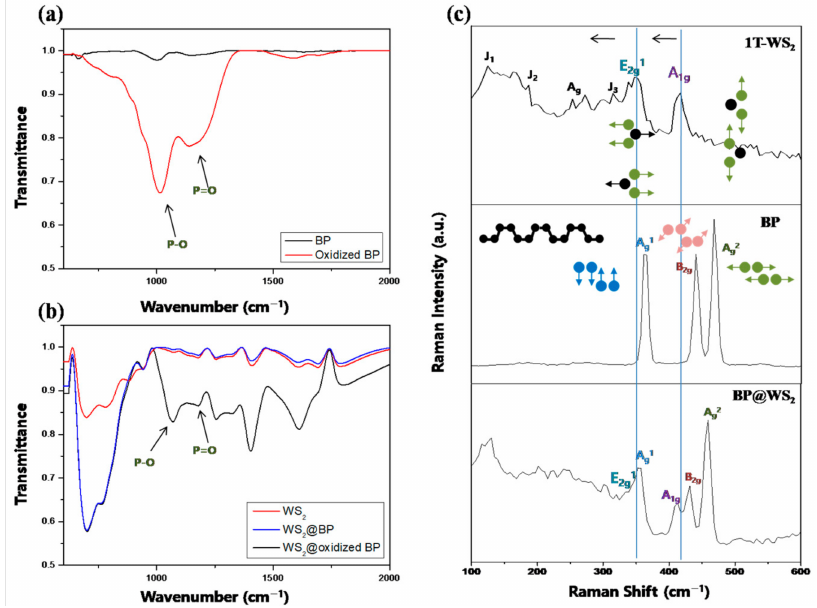
Figure 4. ( a , b ) FT-IR and ( c ) Raman spectra of 1T-WS 2 , OBP and OBP/1T-WS 2